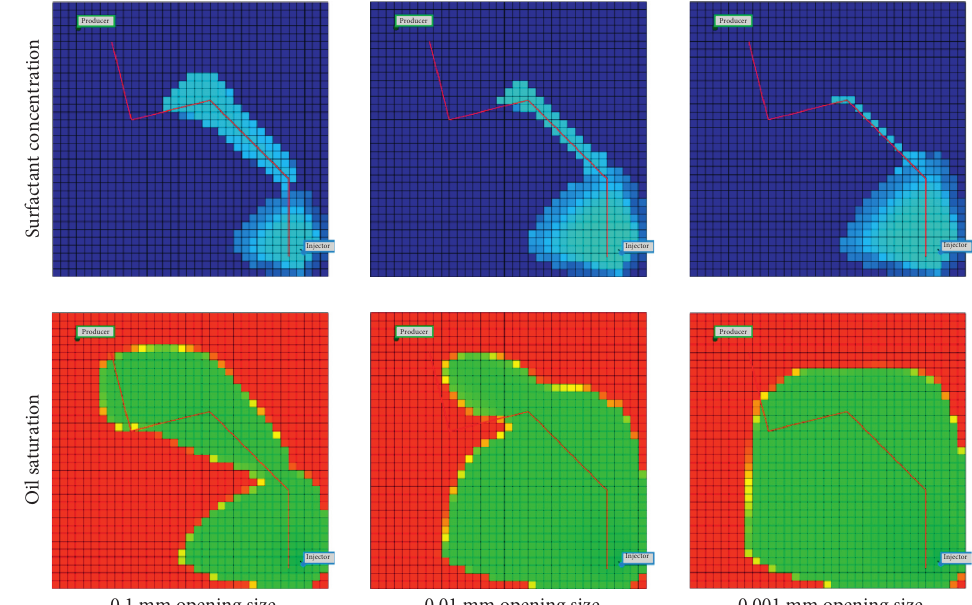
Figure 14: Distribution of chemical agent concentration and oil saturation after surfactant injection in fractured reservoirs with variable opening sizes.